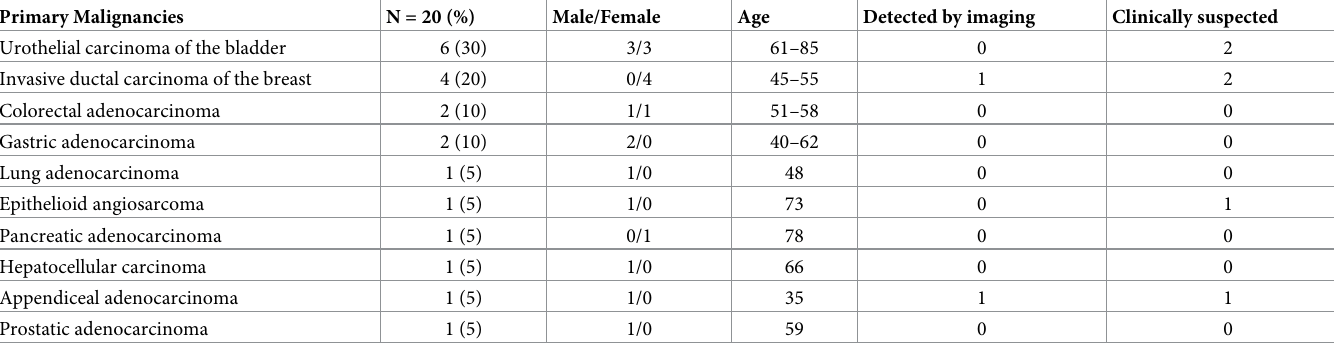
Table 1. Primary malignancies in autopsy cases with pulmonary tumor embolism. Primary